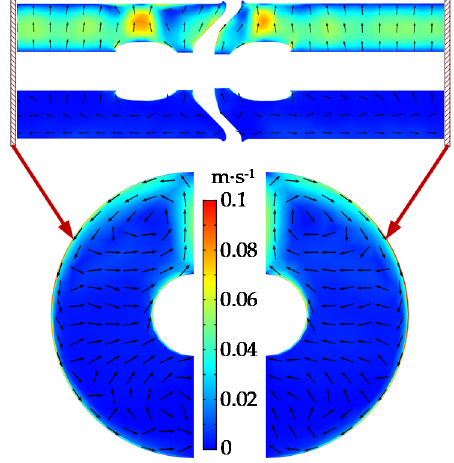
Figure 7. Velocity distribution in SF 6 gas for different cross-section views.